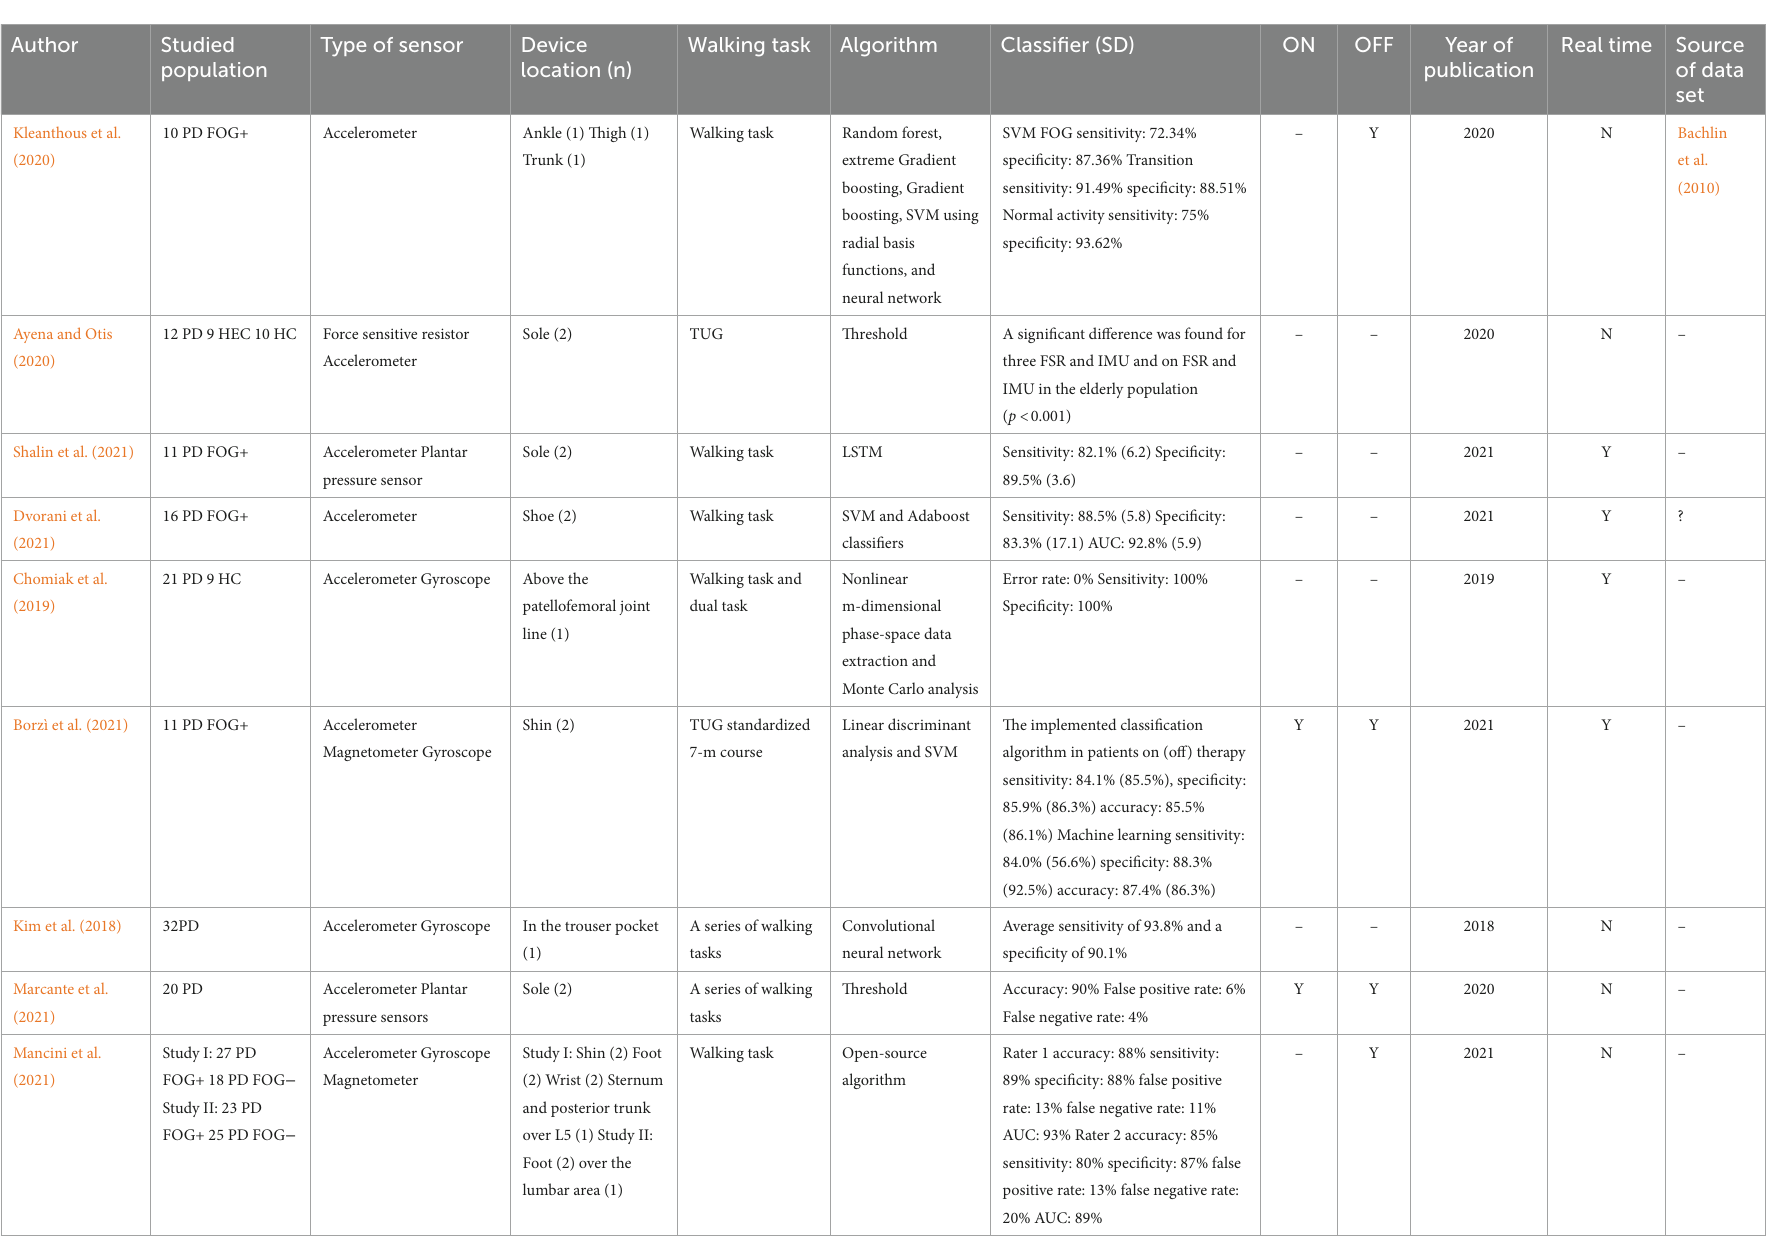
algorithm in patients on (off)